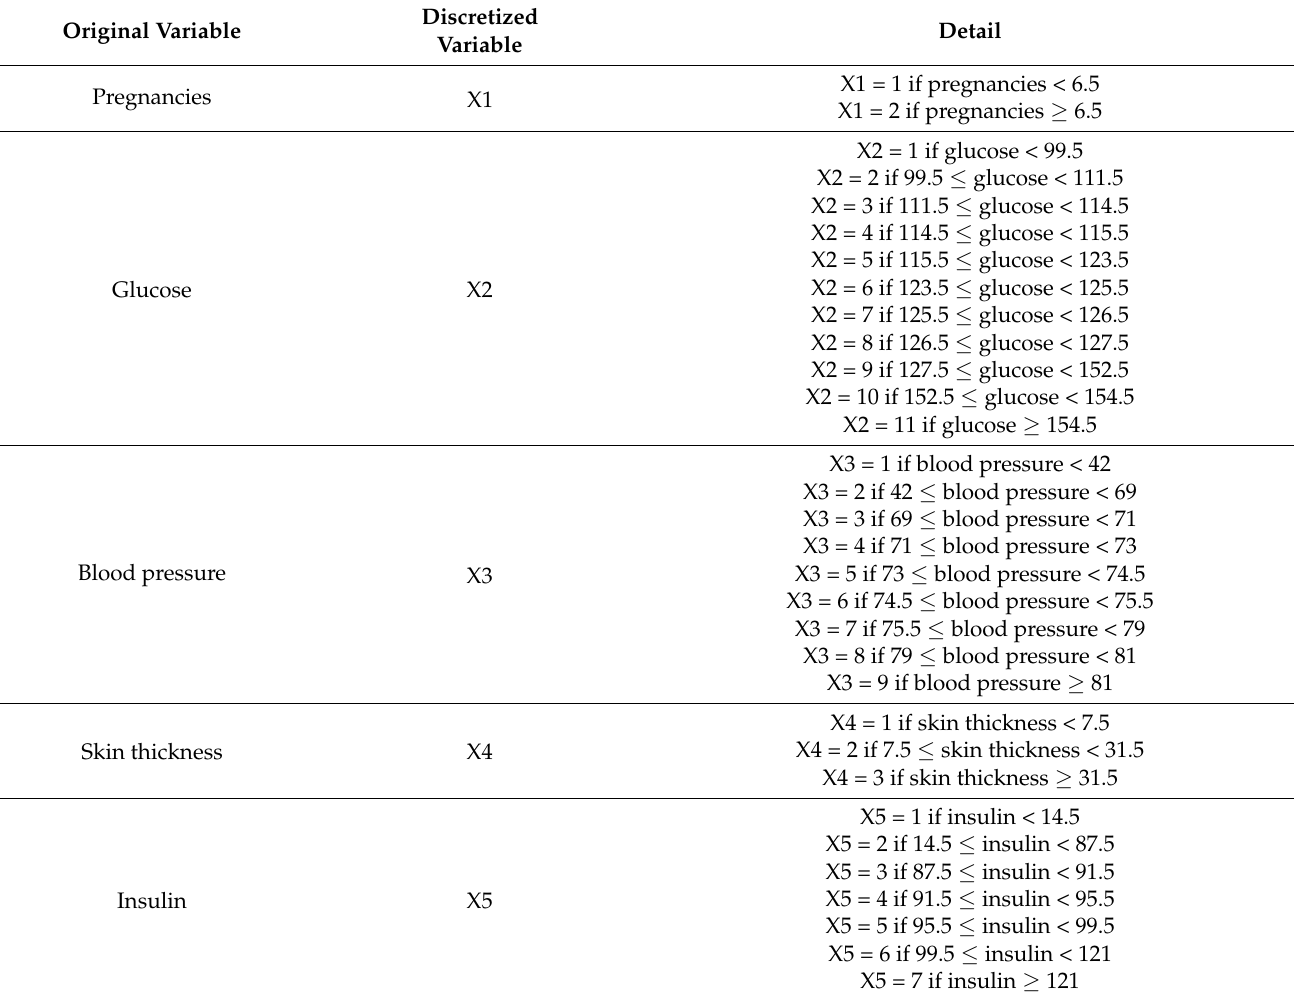
Table 5. Discretized variables generated by the classification tree: diabetes